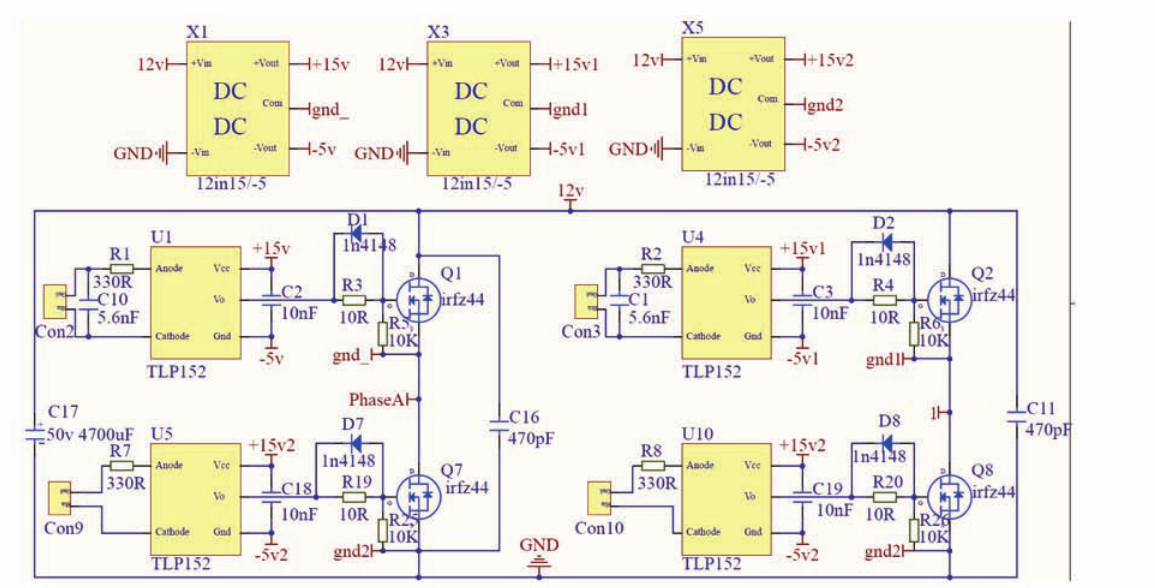
Fig. 2. Residual history for Example 2.